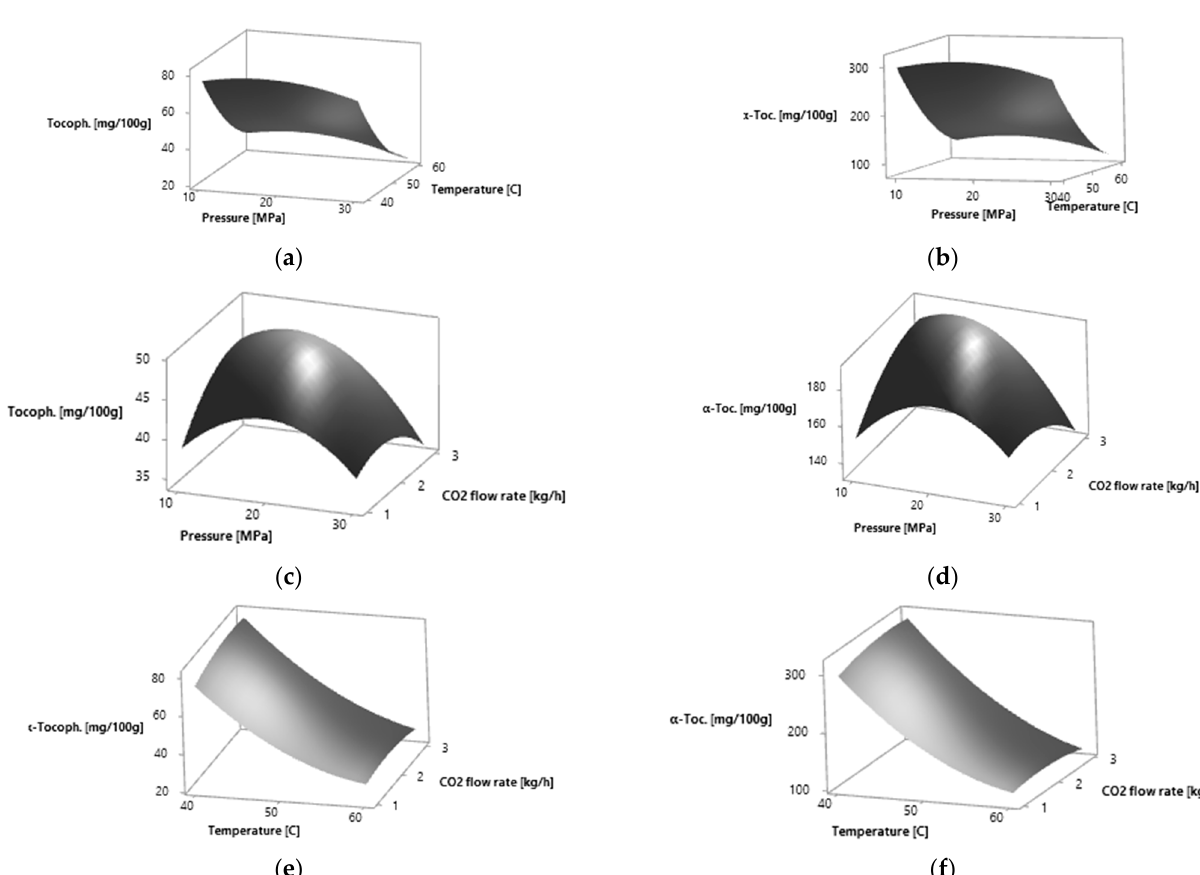
Figure 2. Response surfaces for effects of two independent variables on the α -tocopherol relative amount of P. persica leaves by SC CO 2 extraction: ( a ) pressure (MPa) and temperature (°C) for yellow leaves; ( b ) pressure (MPa) and temperature (°C) for amber leaves; ( c ) pressure (MPa) and CO 2 flow rate (kg·h − 1 ) for yellow leaves; ( d ) pressure (MPa) and CO 2 flow rate (kg·h − 1 ) for amber leaves; ( e ) temperature (°C) and CO 2 flow rate (kg·h − 1 ) for yellow leaves; ( f ) temperature (°C) and CO 2 flow rate (kg·h − 1 ) for amber leaves.